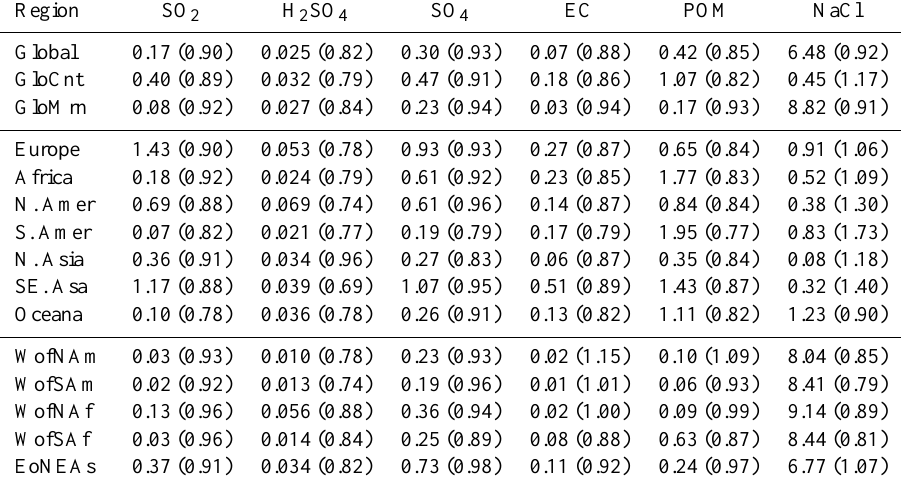
Table A1. Summary of annual-mean concentrations of SO 2 , H 2 SO 4 , and mass of sulphate, EC, POM and sea-salt simulated by GLOMAP- mode (improved configuration) with the ratio to that simulated by GLOMAP-bin shown in parentheses. Units for the GLOMAP-mode simulated values are µgSm − 3 for H 2 SO 4 , µgSm − 3 for SO 2 and SO 4 , µgCm − 3 for EC and POM and µgm − 3 for NaCl. Regions match those defined in Merikanto et al. (2009).